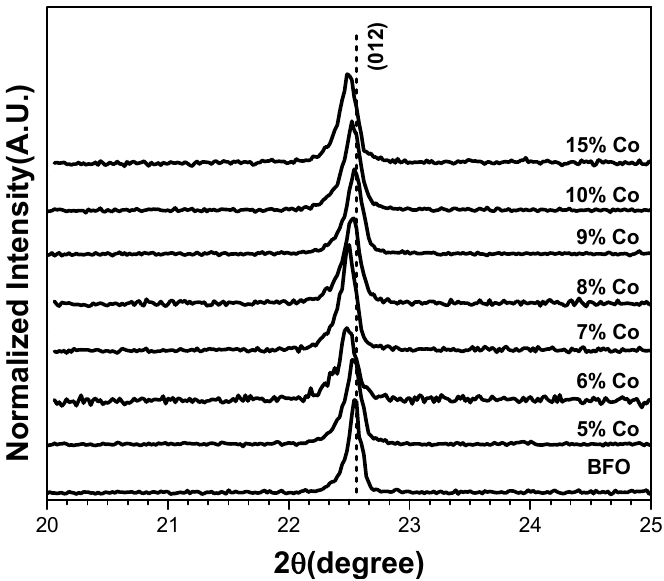
Figure 2. Detail of (012) peak shift for Co-doped BFO powders thermally treated at 700 °C for 30 min.